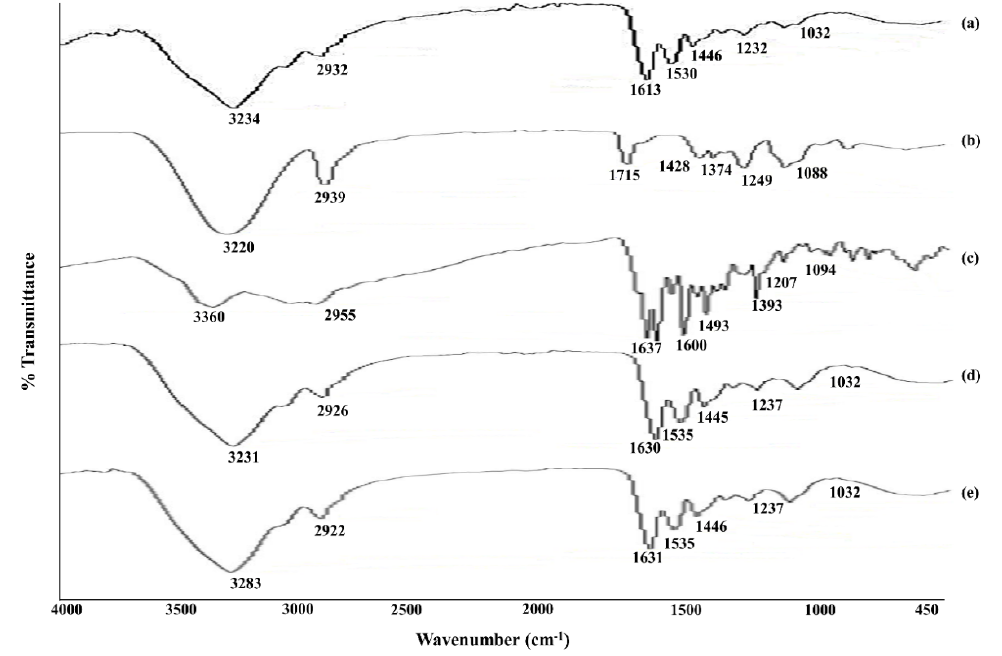
Figure 6. FTIRspectraof( a )purePVA,( b )pureGel, ( c )MTX,( d )unloadedGel/PVAhydrogel, ( e Figure 6. FTIR spectra of ( a ) pure PVA, ( b ) pure Gel, ( c ) MTX, ( d ) unloaded Gel/PVA hydrogel, ( e ) MTX-loaded Gel/PVA hydrogel.